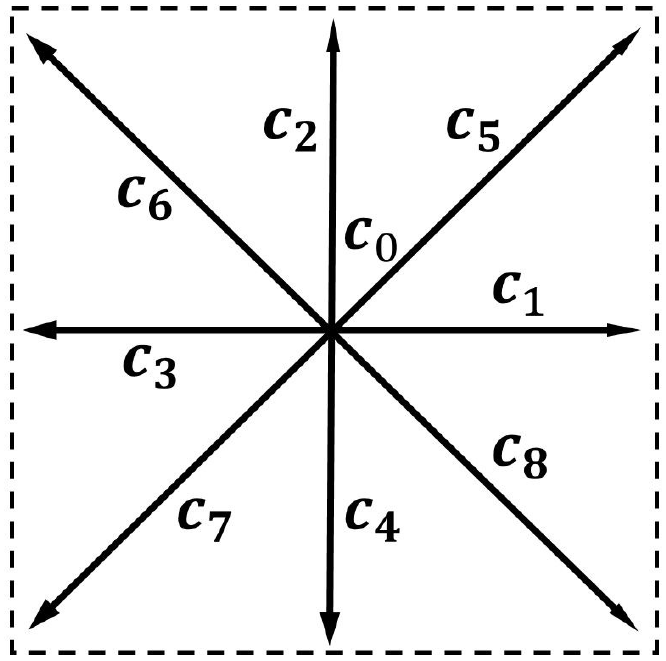
Figure 1. Schematic of the D2Q9 lattice